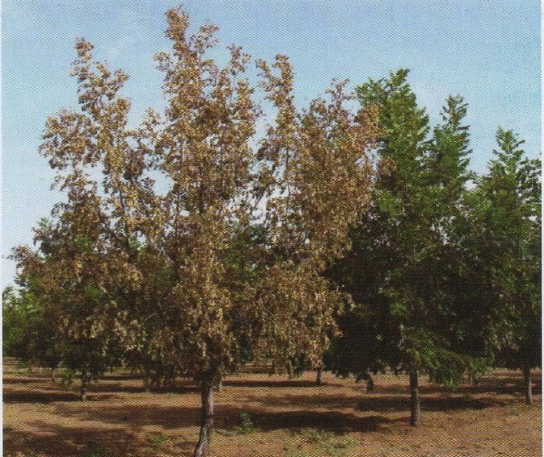
Figure 2. Pecan tree that suffered sudden death from phymatotrichopsis root rot, where the brown